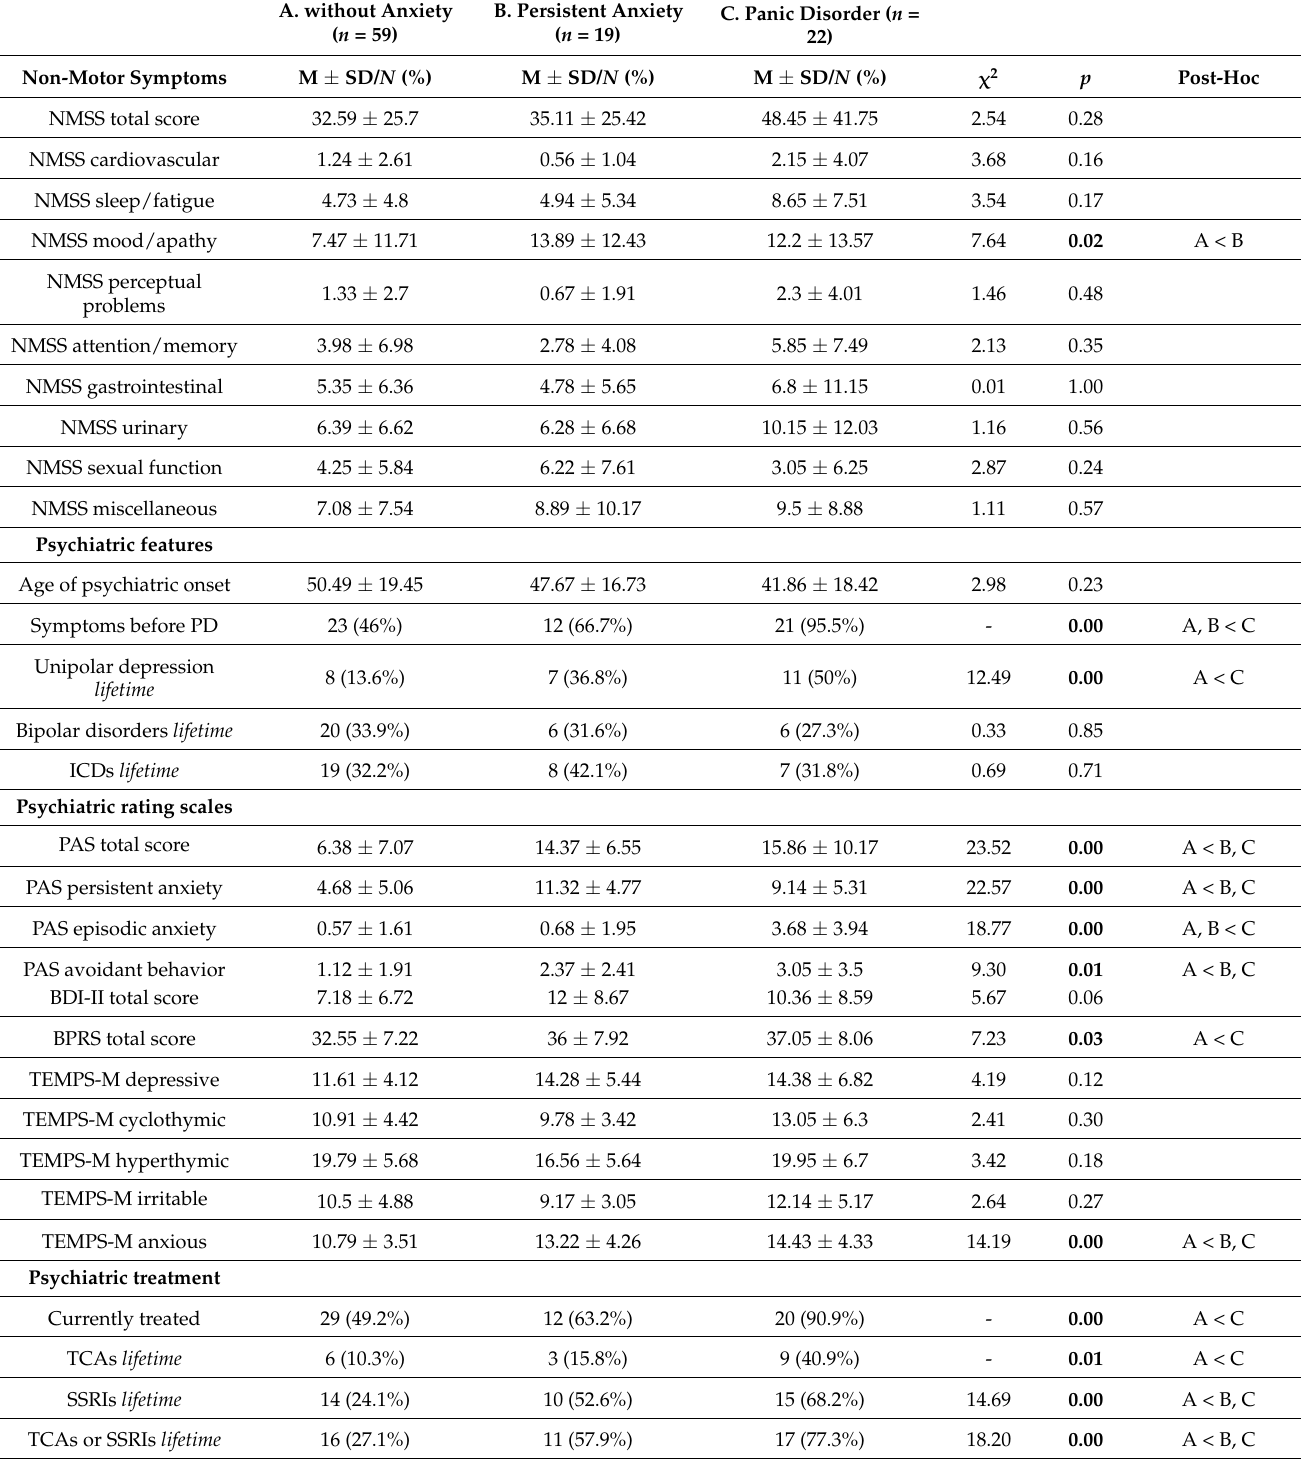
Table 3. Differences in non-motor symptoms and psychiatric features among PD patients without anxiety disorders, with lifetime persistent anxiety disorders or with lifetime panic